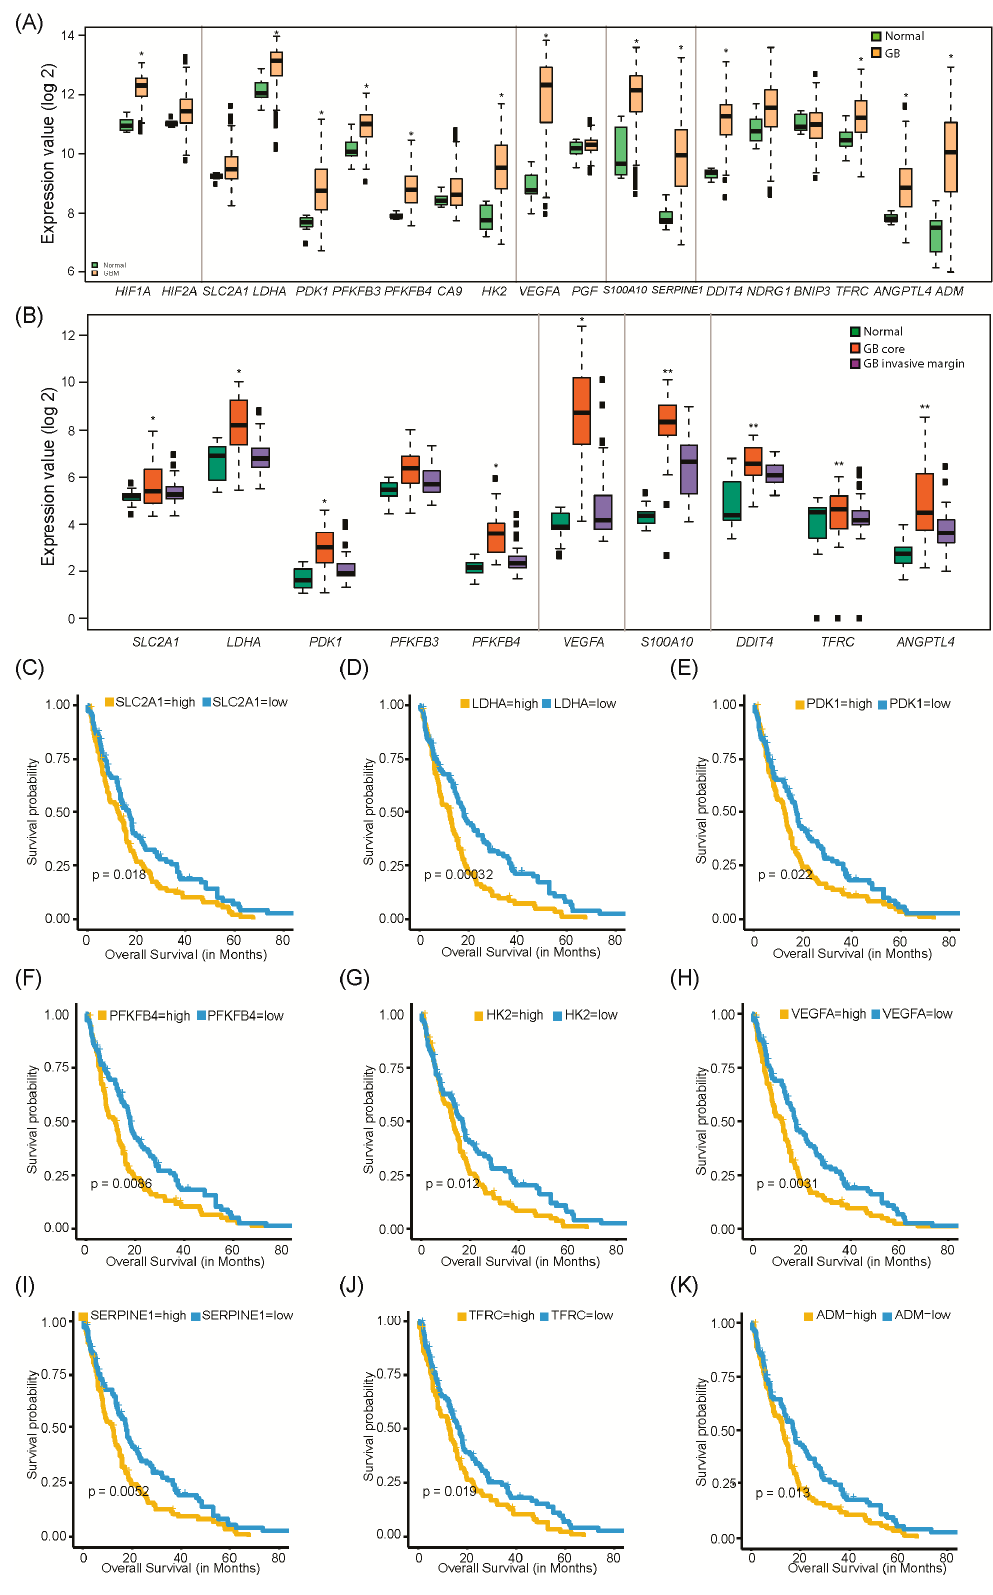
Figure 8. Expression of hypoxia-related genes in GB patients. ( A ) Expression of selected hypoxia- related genes in normal brain and GB patient samples. Data sourced from the published study with